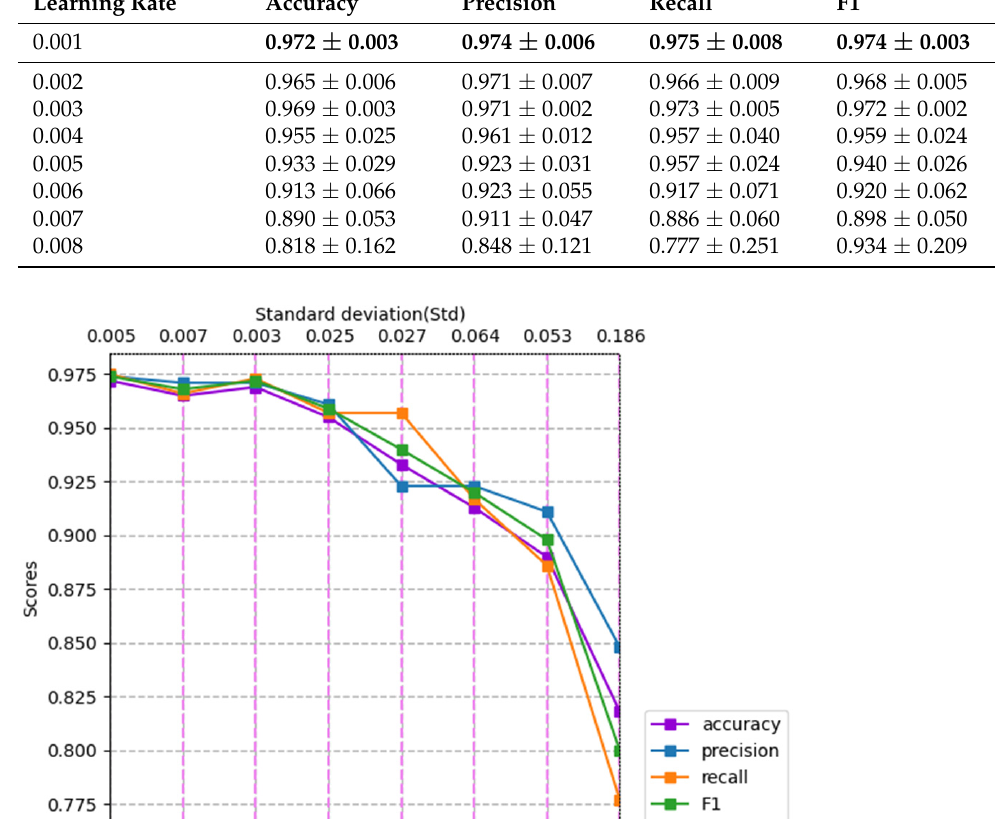
Table 4. Performance of MCNN-IFGS on the Chinese review dataset. Here, different learning rates were used to carry out experiments. The value before “±” was the mean value, followed by the standard deviation. Learning Rate Accuracy Precision Recall F1